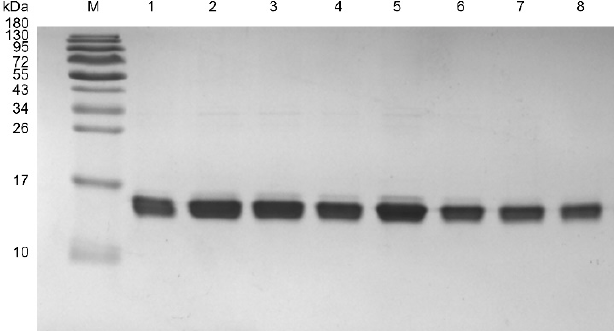
Figure 4. SDS-PAGE analysis for purified VHHs. M, molecular weight marker; 1–8, M0–M7. 10 µ L for protein concentration 3 µ g.